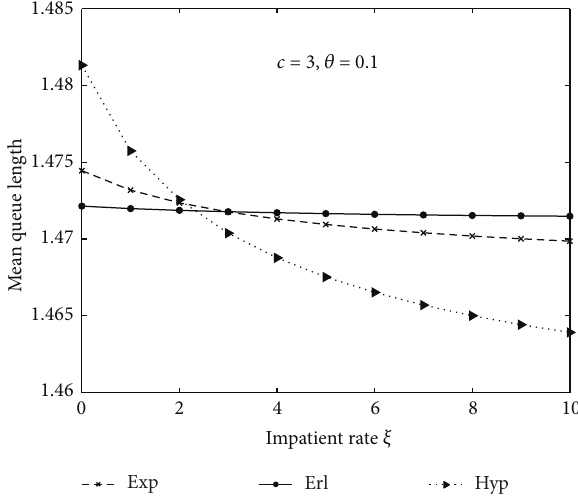
Figure 9: Mean queue length versus vacation-service rate with 𝜌 = 0.1 , 𝜉 = 10 , 𝜃 = 0.1 , and 𝑐 = 6 .